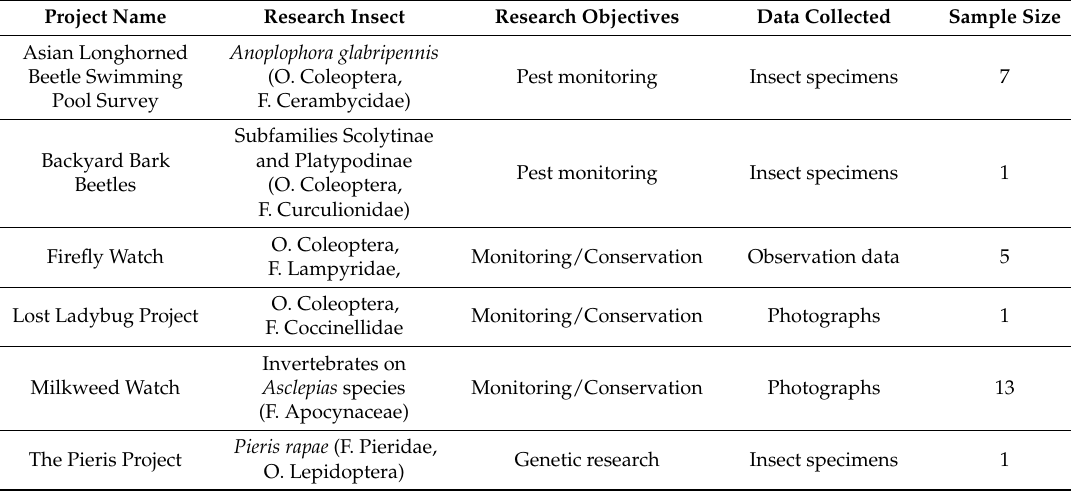
Table 2. Citizen science program characteristics including project name, Order (O.) and Family (F.) of research insect, research objectives, data collected by citizen scientists and the number of research participants from each project (sample